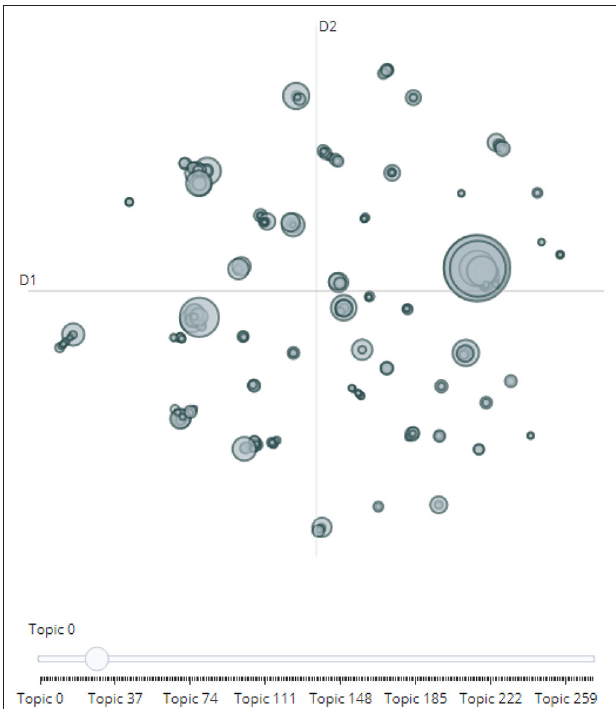
FIGURE 3 | BERTopic’s interactive intertopic distance